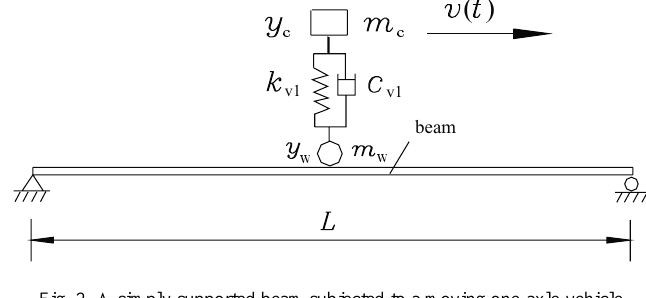
Fig. 2. A simply supported beam subjected to a moving one-axle